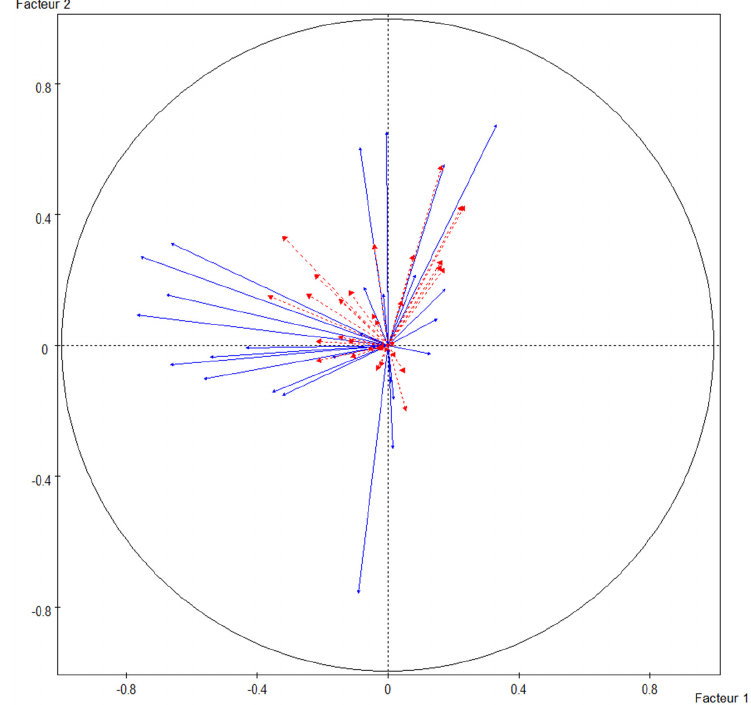
Land 2023 , 12 , x FOR PEER REVIEW Figure 5. Biplot of PCA in the southern district. Figure 5. Biplot of PCA in the southern district.